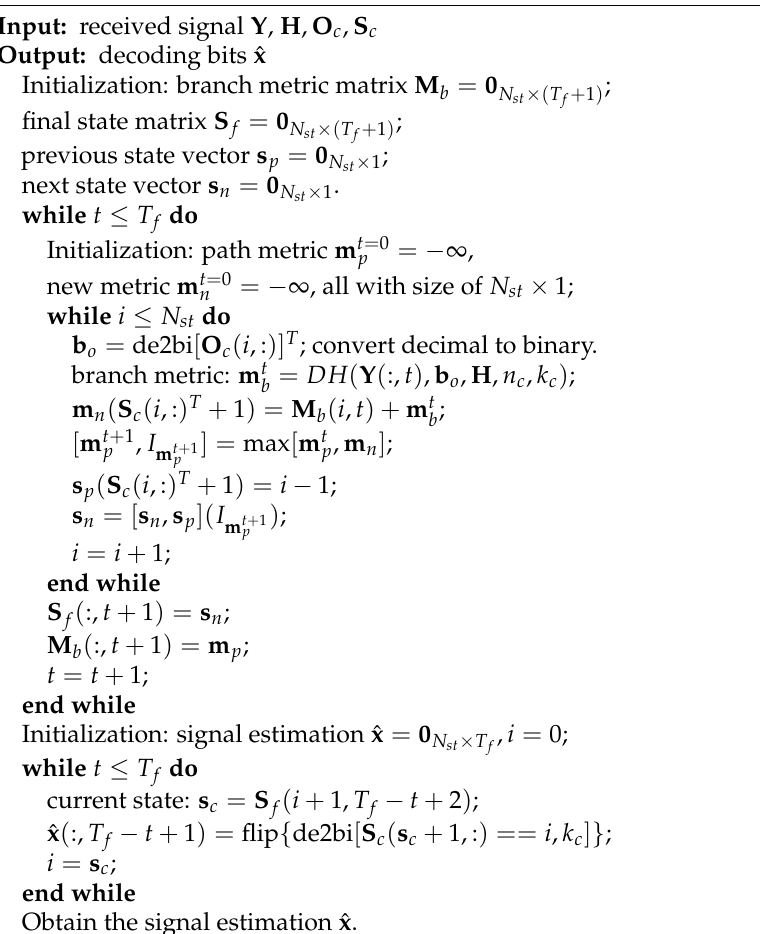
Algorithm 1 The pseudo codes of the joint decoding